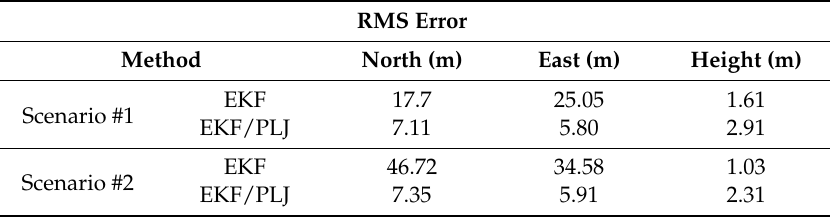
Table 3. North, East & Height